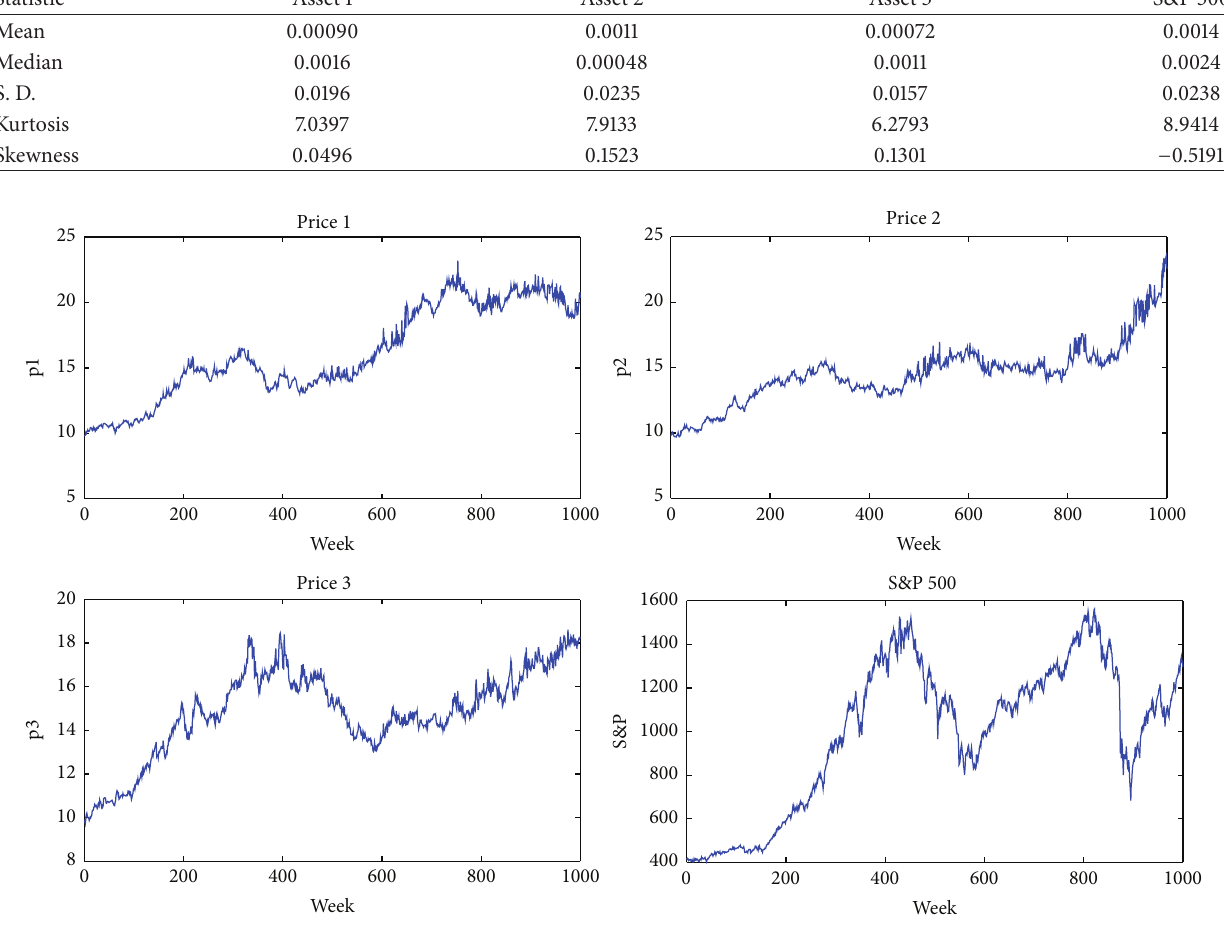
Figure 1: Evolution of prices of the three simulated stocks and the S&P 500